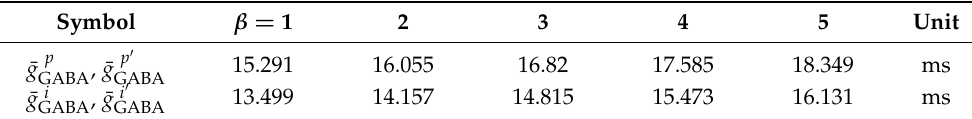
Table 6. Average GABAergic conductance values for the two-cortical-column model where = 10. ¯ g p , i , p (cid:48) , i (cid:48) AMPA Symbol β = 1